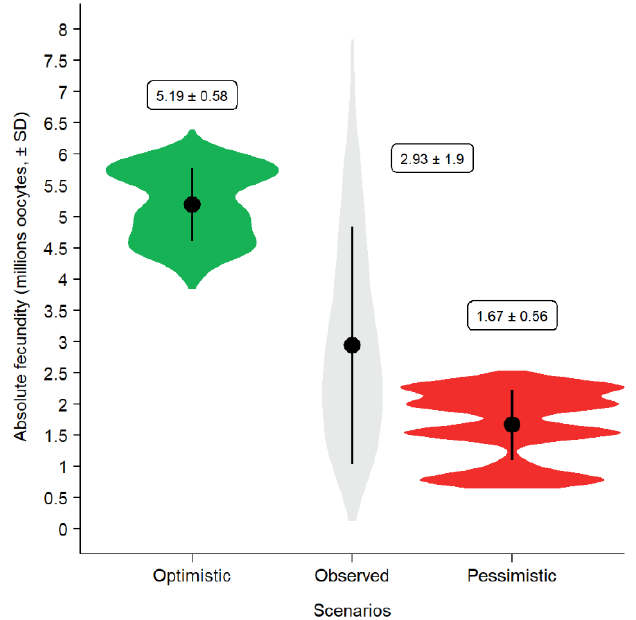
Figure 5. Impact of an increasing bioaccumulation gradient on European eel fecundity. Violin plot and averages (black dots, ± standard deviation SD) of the absolute fecundity (million oocytes per eel) estimated from the length of sampled eels and simulated eels in optimistic (low bioaccumulation) and pessimistic (high bioaccumulation) scenarios according GCP models (geographic, local and contamination predictors).